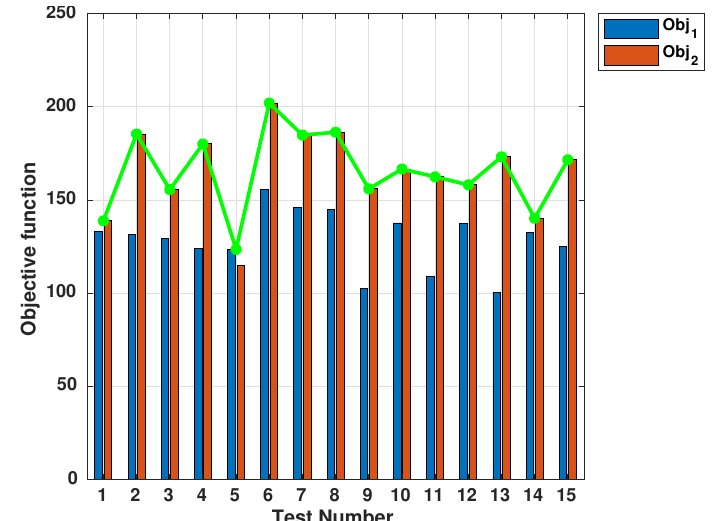
Figure 11. Test 4—objective functions Obj 1 (blue bar: standard extraction process), Obj 2 (red bar: fermentation-based extraction process) and max ( Obj 1 , Obj 2 ) (green line). Table 7. Test 4—DSS results for α = 0.34, β = 0.33 and γ = 0.33 and variations in processing